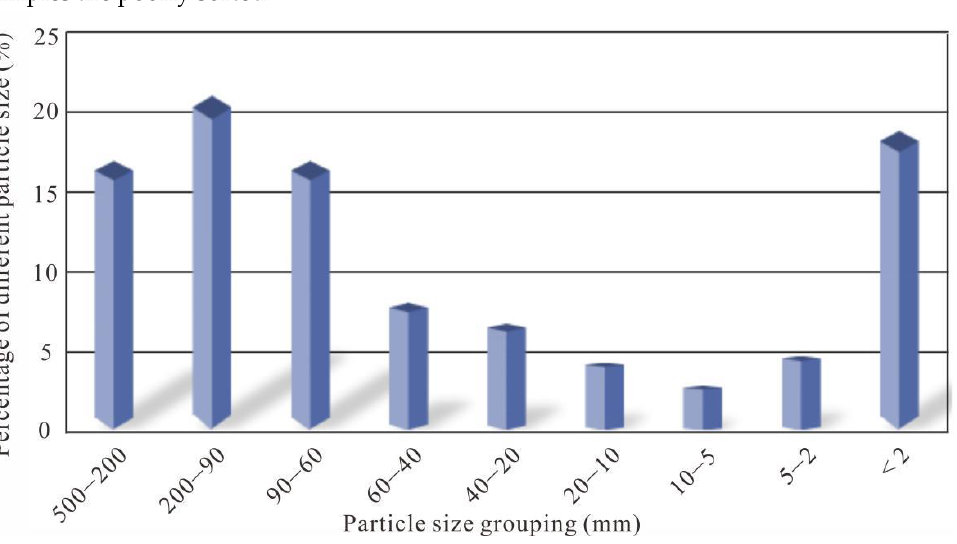
Figure 3. Intact glacial till sample. ( a ) Field sampling point of glacial till. ( b ) Cylindrical gacial till sample.